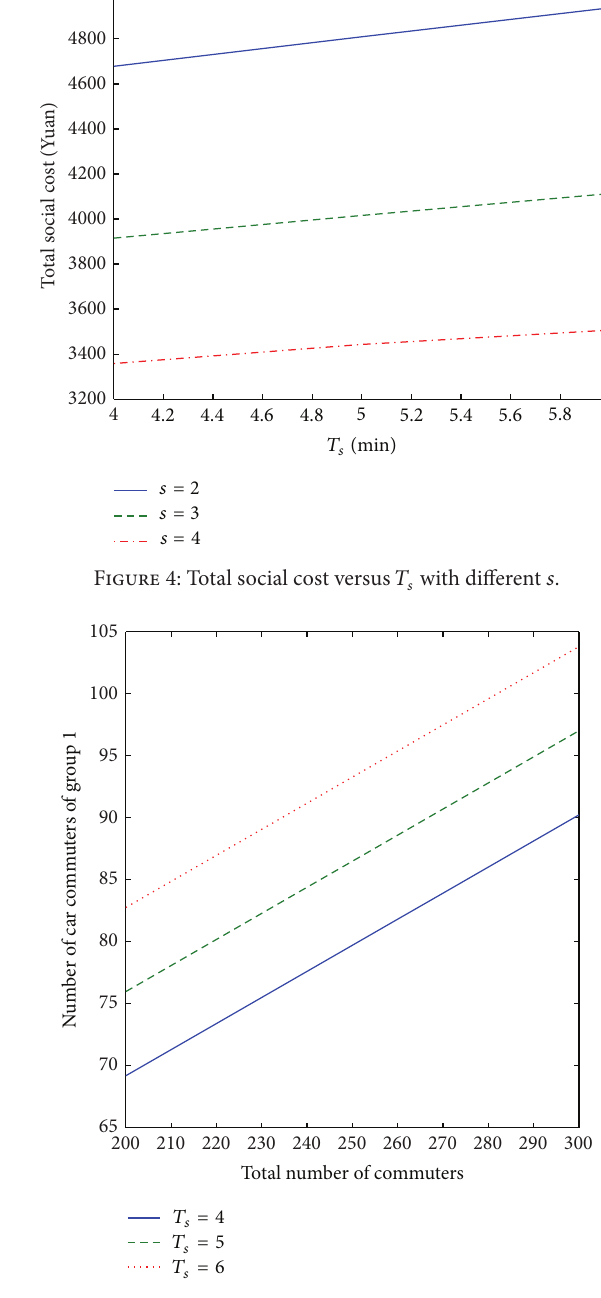
Figure 5: 𝑁 𝐴1 versus 𝑁 with different 𝑇 𝑠